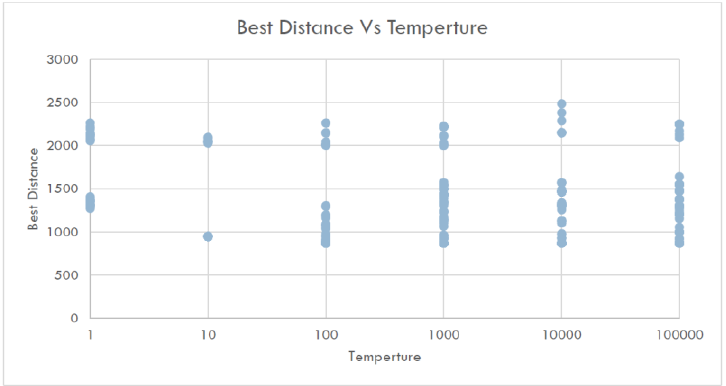
Fig. 6. Route Best Distances Compared to